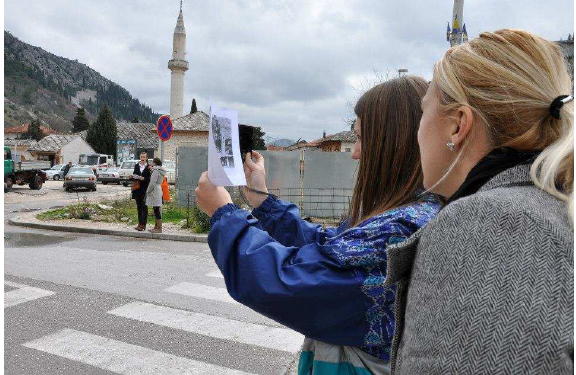
Figure 5 Participants in Stolac using GPS cameras and prints of historic photos to understand the past and document the present. The GPS enabled cameras and on-line collaborative mapping tools with tablet computers and smart phones were also used. While collecting information the participants deliberated over how to best represent Stolac and shared their observations and related personal stories. This led to a rich collection of images and many times surprising